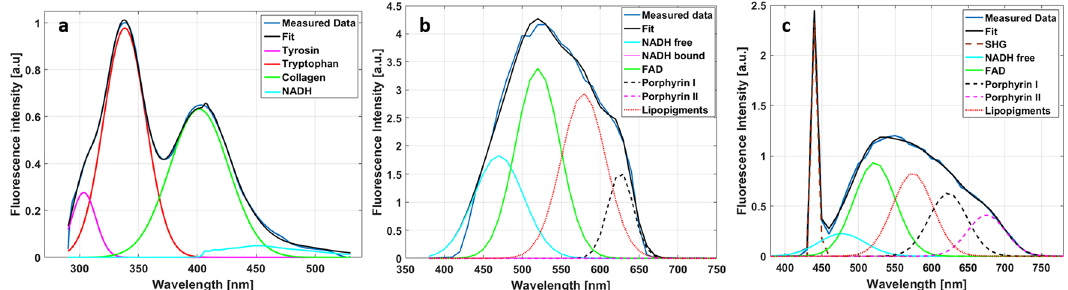
Figure 9. Examples of spectral fitting of DUV and NIR collected data. ( a ) Fitted spectrum acquired using 275 nm as excitation wavelength ( a ); ( b ) fitted spectrum acquired using 810 nm as excitation wavelength; ( c ) fitted spectrum acquired using 890 nm as excitation